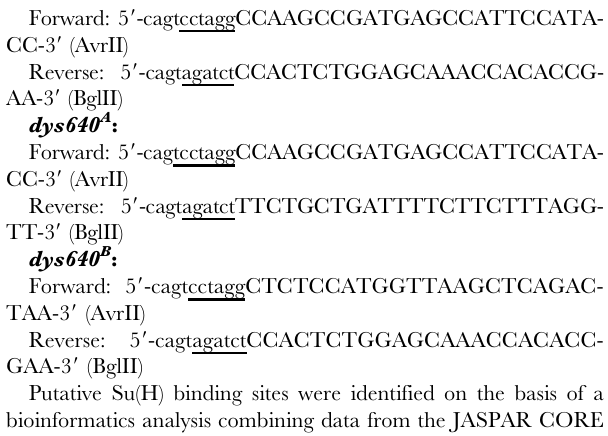
Figure S1 Genomic localization of the dys Janelia lines. Schematic representation of dys cis -regulatory region (top). Black horizontal bars represent the DNA elements available in the Janelia database. Two Janelia lines (GMR_13D07 and GMR_13B03, green bars) drove GFP expression in the tarsal segments of the leg and in the antenna imaginal discs (green). Dll (red) and Hth (blue). Images are obtained from the flylight database. (TIF) Figure S2 dys gain and loss of function phenotypes. (A–B) SEM imaging close view of the tibial/tarsal joint in a (A) wild type and (B) dys 2 /dys 3 mutant legs. (C) ptc-Gal4 , UAS -GFP ; UAS- dys -RNAi (green) prepupal leg disc. dys -RNAi construct efficiently downreg- ulates Dys protein levels (red and single channel in C 9 ). Dlg is in blue. (D) Adult leg of a ptc - Gal4 ; UAS- dys ; tubGal80 ts fly. Temporally restricted ectopic expression of dys along the PD axis of the leg induced the formation of a fold in tarsal segments and the tibia (tib) (arrows). (E–G) Third instar leg imaginal discs stained with Dlg (red) of the following genotypes: (E) ptc - Gal4 , UAS- GFP , (F) ptc - Gal4 , UAS- GFP ; UAS- dys ; tubGal80 ts and (G) Notch tsa ; ptc - Gal4 , UAS- GFP ; UAS- dys ; tubGal80 ts . Cross-section of the leg imaginal disc and single channels for Dlg are also shown. Arrows indicate the presence of folds in the epithelium. (TIF) Figure S3 dys relation with the pro-apototic gene hid and P- Mad. (A) hid-Z (red) and dys (green) expression in a prepupal leg disc. (A 9 and A 0 ) Close view of two tarsal joints. Note that hid expression (red outline in A 0 ) extends a couple of cells distal to Dys. (B) en-Gal4 , UAS -GFP ; UAS- dys -RNAi (green) downregulates hid-Z expression (red and single channel in B 9 , arrow). (C) en- Gal4 , UAS -GFP ; UAS- dys; tubGal80 ts (green). Misexpression of dys for 24 hrs in the posterior compartment cell autonomously activates hid-Z expression (red and single channel in C 9 , arrow). (D) en-Gal4 , UAS -GFP ; UAS- dys; tubGal80 ts (green). Misexpres- sion of dys for 24 hrs induces caspase activity (DCas-3, red and single channel in D 9 ) in the posterior compartment in a prepupa leg. The domain of dys misexpression is outlined in green. (E) P- Mad staining (red) and bib-Z (green) expression in a prepupal leg. Single channels for P-Mad (E 9 ) and bib-Z (E 0 ) are shown. (TIF) Figure S4 dys 640 CRM is regulated by Notch signaling. (A) ptc - Gal4 , UAS- GFP ; UAS- Notch -RNAi; tubGal80 ts (green). Notch knockdown downregulates dys640-Z expression (red and single channel) in a prepupal leg disc. (B) ptc - Gal4 , UAS- GFP ; UAS- Notch ICD ; tubGal80 ts (green). Notch pathway activation induces dys640-Z expression (red and single channel) in the tarsal segments in a third instar imaginal disc. Note that although Notch pathway activation is induced along the PD axis, dys640-Z expression is restricted to the distal domain of the leg.